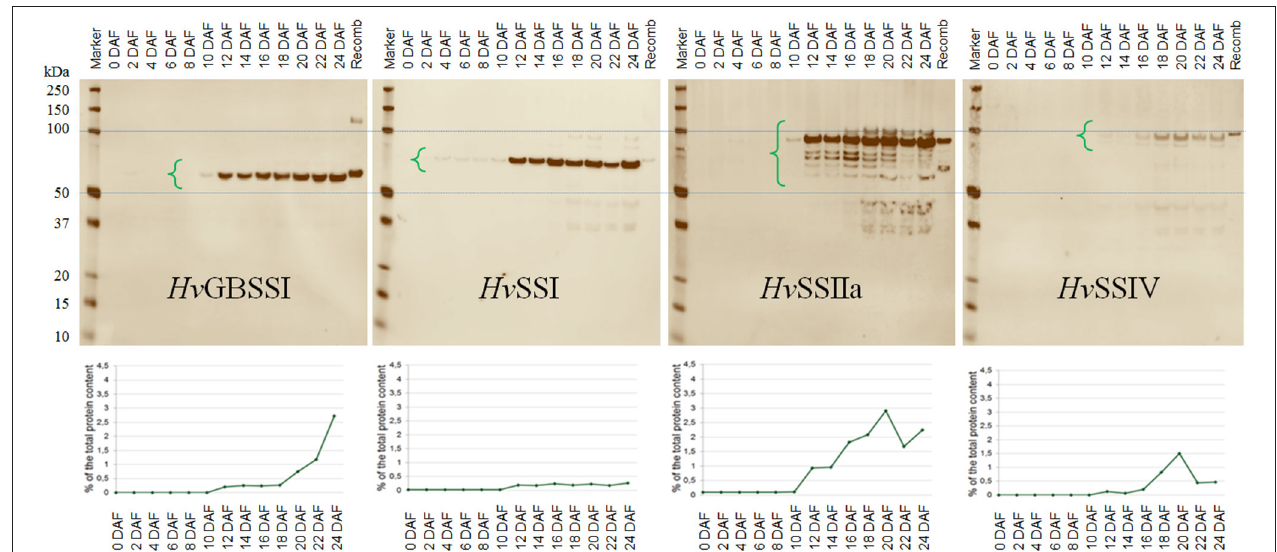
FIGURE 7 | Temporal profile of protein abundance in barley endosperm. Barley grains were harvested between 0 and 24 DAF every 2 days and proteins from barley endosperm extracted. Equal amounts of protein were loaded onto SDS-PAGE and probed with the indicated primary antibodies. The horizontal blue lines show the alignment of the molecular weight markers around the relevant area. (Top) Immunoblots using the indicated antibodies; protein ladders are included in the left of each immunoblot and corresponding molecular weights are indicated to the left of the group. The rightmost lane in each blot shows recombinant enzyme controls added to each gel, of the same type that the antibodies were raised against. The molecular weights of the bands being integrated are: Hv GBSSI, 59.0kDa (61.3kDa for the recombinant version); Hv SSI, 67.5kDa (69.8kDa for the recombinant version); Hv SSIIa, 81.6kDa (84.6kDa for the recombinant version); Hv SSIV, 98.3kDa (99.1kDa for the recombinant version). The region used for integration in each case is illustrated with open green brackets; it is larger for SSIIa because the multiple bands were interpreted as being fragments of SSIIa, since their presence and pattern were occasionally detected also in SDS-PAGE of recombinant protein preparations; in any case, the band at 81.6kDa dominates the overall intensity. (Bottom) Semi-quantitative analysis of protein abundance, ordered as for the immunoblots. The x-axis shows time as DAF, the y-axis shows protein quantity as calculated from immunoblot as percentage of total protein